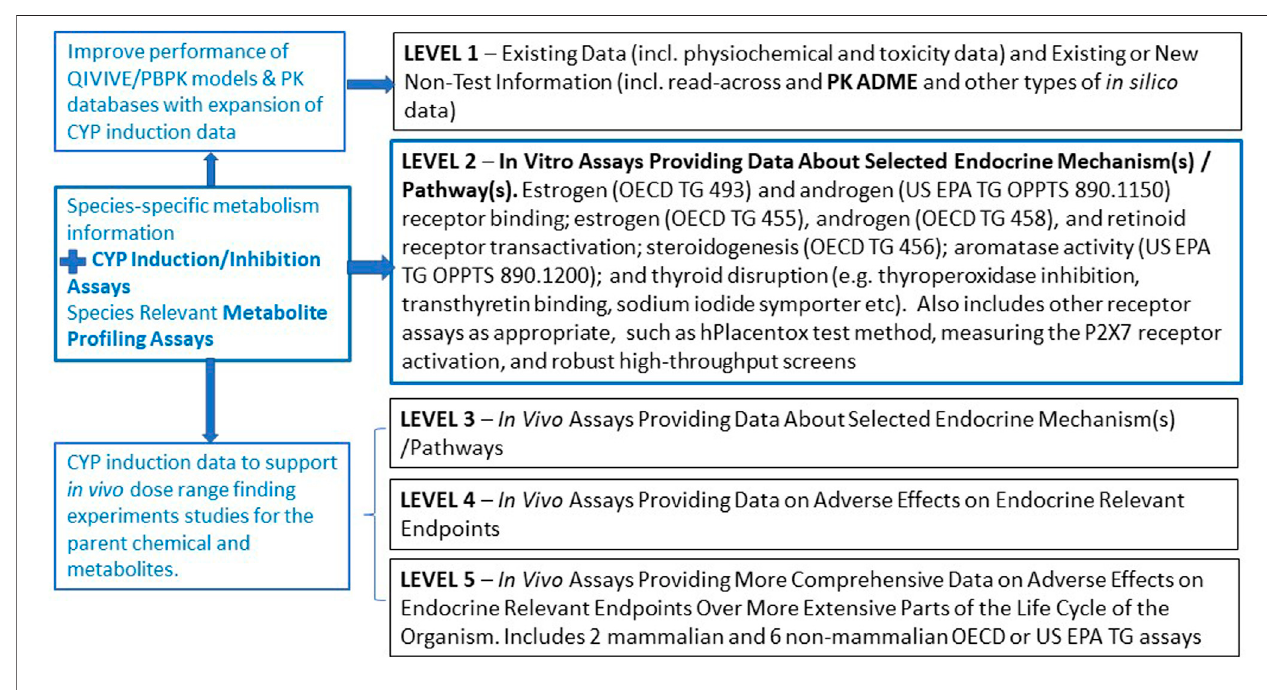
FIGURE 1 | Selected illustrations of regulatory applications of in vitro metabolism test method/systems falling within the OECD TG Programme. panel (A) Introduction of metabolism in vitro testing at Level 2 of the OECD Conceptual Framework for Testing and Assessment of Endocrine Disrupting Chemicals (EDCs).